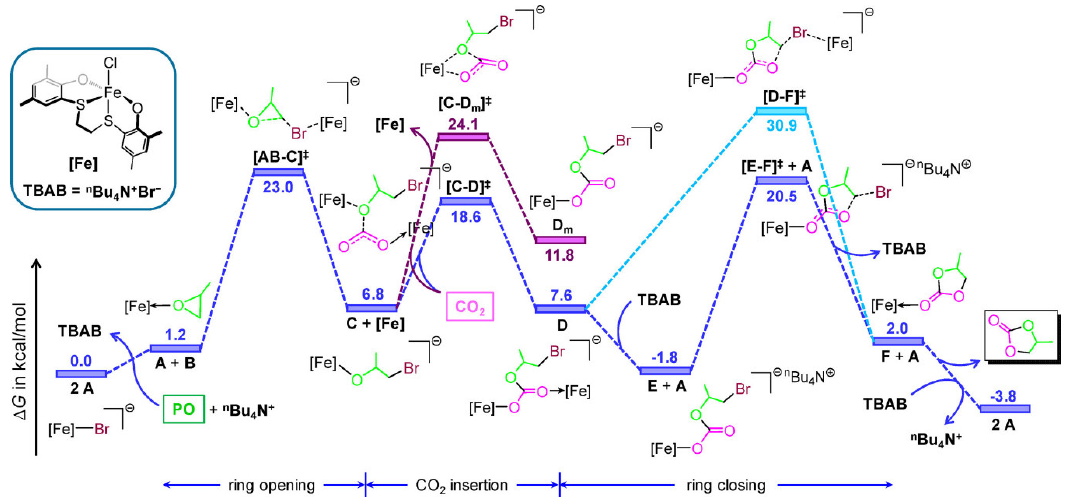
Figure 16. Free energy profile for the coupling of PO and CO 2 promoted by complex 20 [52]. Reprinted with permission from ref. 52. Copyright (2020) American Chemical Society.